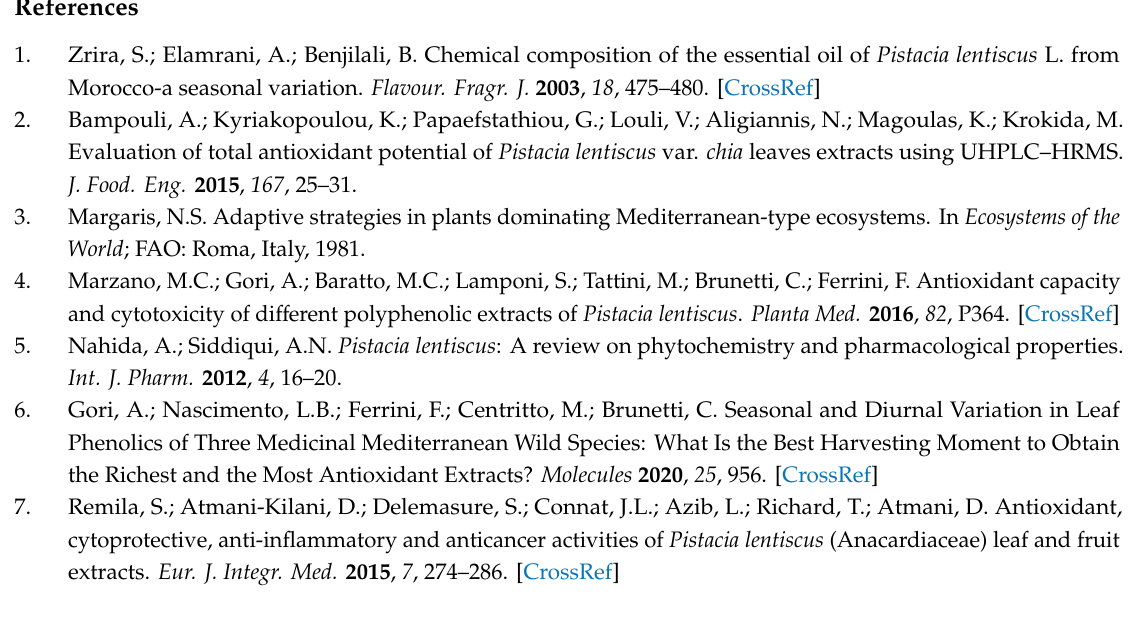
Table S1:Polyphenolic content (in mg g − 1 DW) of individual tannins and gallic acid derivatives obtained in each trial of the optimization BBD design; Table S2: Flavonoidic content (in mg g − 1 DW) of individual compounds obtained in each trial of the optimization BBD design; Table S3: Regression coe ffi cients (intercept, linear, quadratic, and interaction) of the models obtained for each response (total tannin—TTC, total flavonoids—TFC, myricitrin—MYC, and total polyphenols—TPC contents); Figure S1. MS / MS spectra of tetragalloyl quinic acids (isomer 1, A and isomer 2, B) corresponding to peak 8 and 9 of Table 4,